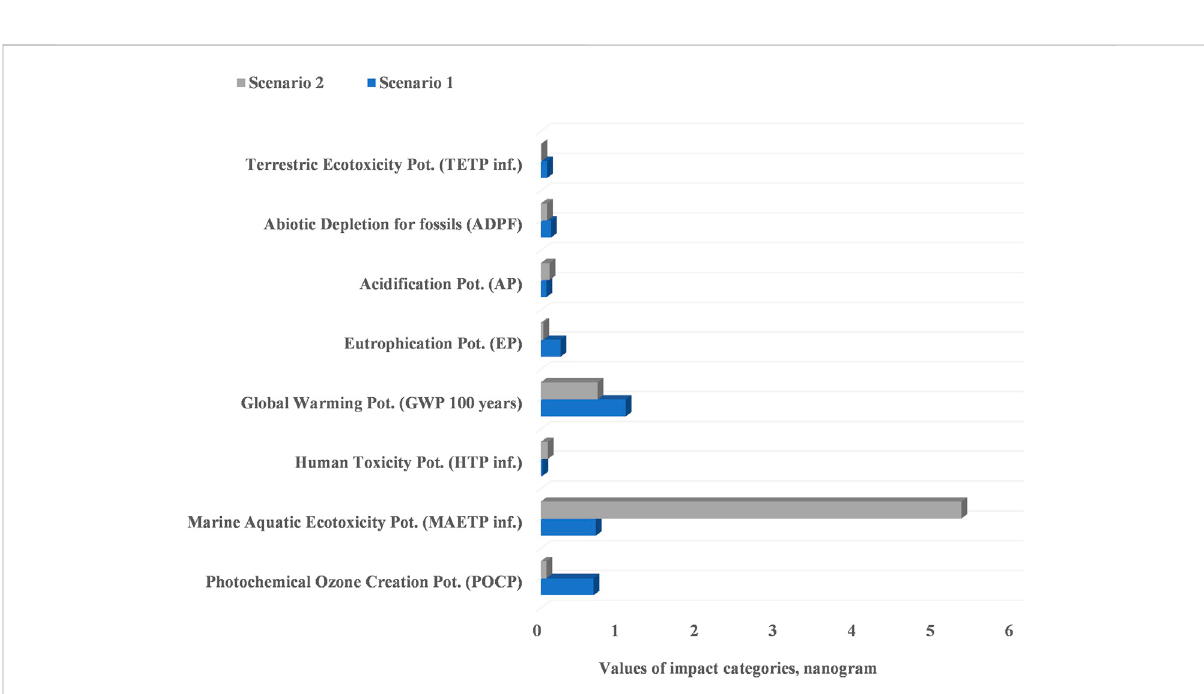
FIGURE 3 Main environmental impact category values for the two examined end-of-life scenarios in nanograms. (Source: own analyzes with GaBi 8.0